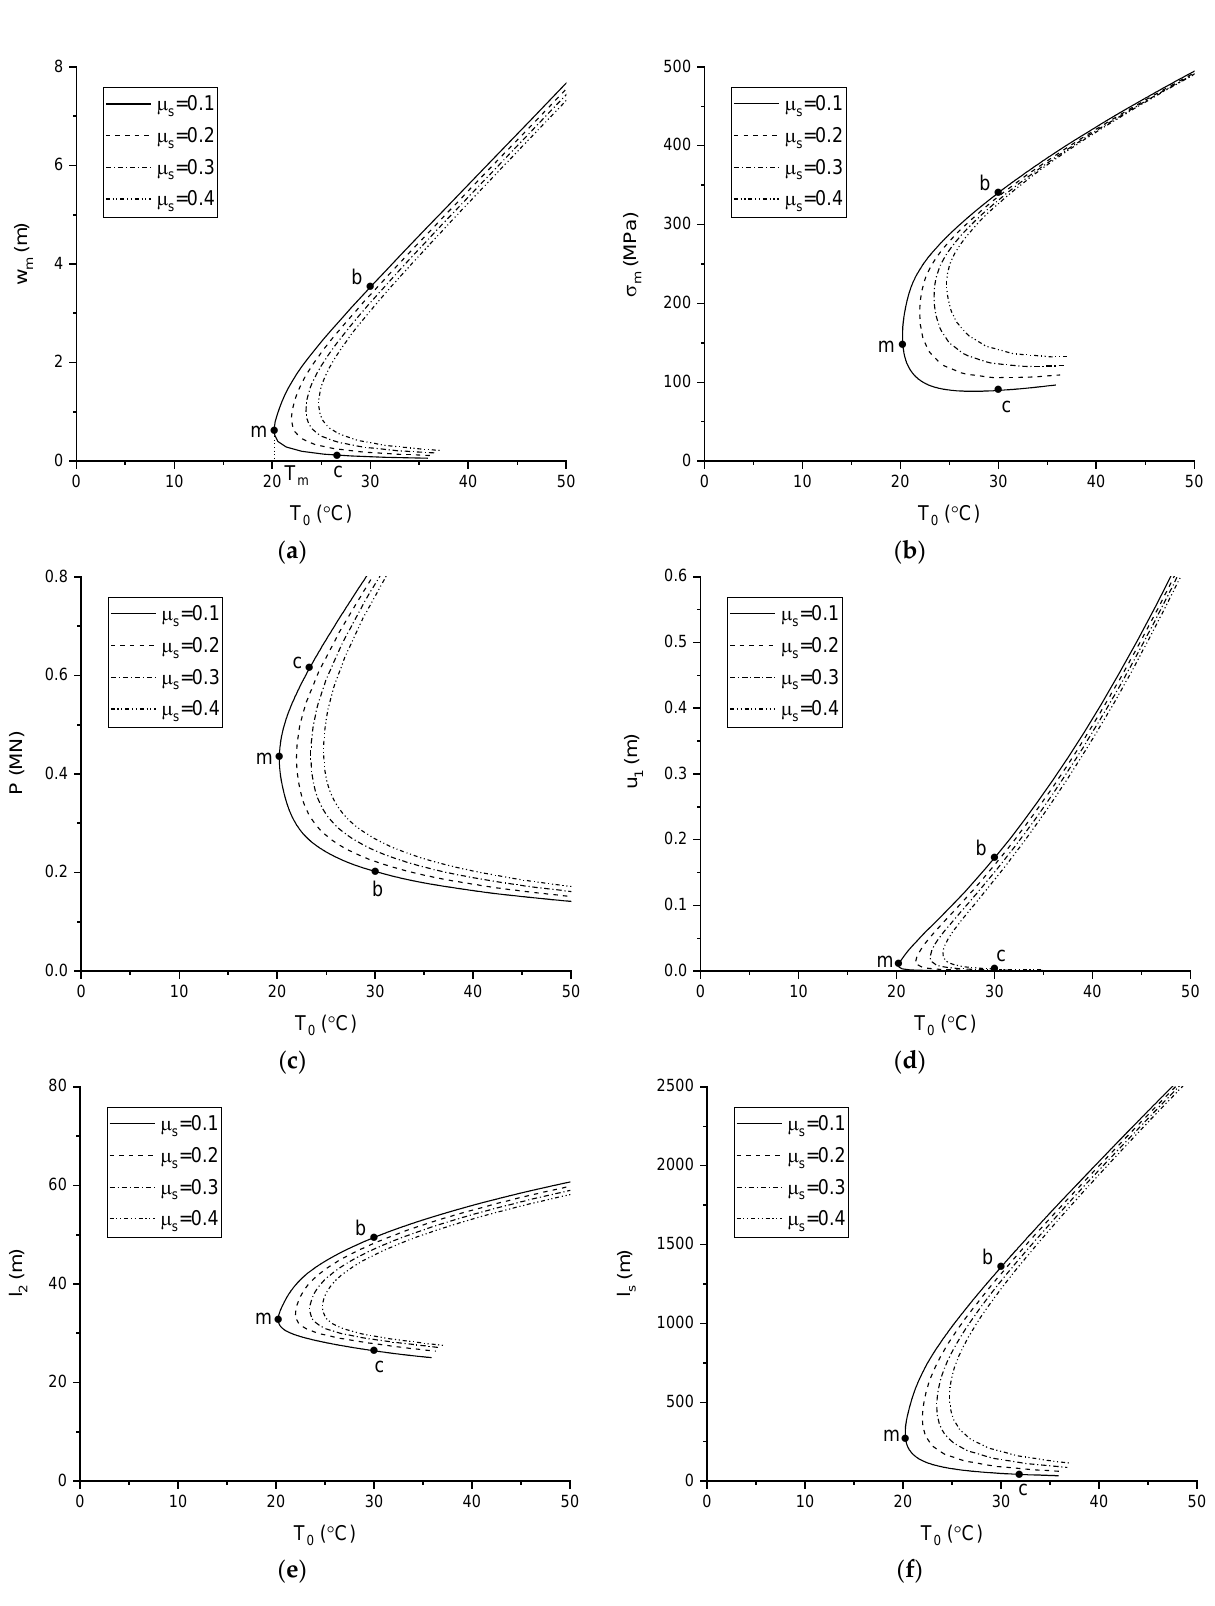
Figure 14. Influence of 𝜇 𝑠 on the buckling behaviour. ( a ) 𝑤 𝑚 . ( b ) 𝜎 𝑚 . ( c ) 𝑃 . ( d ) 𝑢 1 . ( e ) 𝑙 2 . ( f ) 𝑙 𝑠 ( 𝜇 𝑏𝑟𝑘 = 2.0 , 𝑣 𝑜𝑚 = 0.1 m).